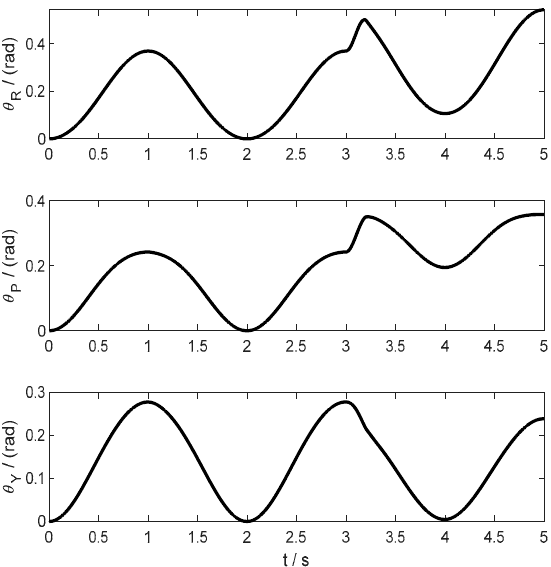
Figure 12. The angle of the platform in the simulation of attitude locking tracking trajectory. The attitude locking tracking trajectory error of the simulation with traditional PID controller, SMC controller, FTSMC controller and NNFTSMC controller is presented in Figure 13. Figure 14 presents the attitude tracking result of the platform. In Figure 15 the angular velocities of the platform in three axes are shown. Figures 13–15 present that the NNFTSMC control law has good anti-interference performance compared to PID, SMC and FTSMC. By using neural networks to add the prediction of friction, NNFTSMC has better stability than FTSMC. The three-axis stabilized platform can maintain the desired attitude relatively well by using NNFTSMC control law. The IAE and ISE results of the simulation of attitude locking are shown in Tables 4 and 5, respectively. Through the simulation of attitude locking, the NNFTSMC control law has better robustness, less